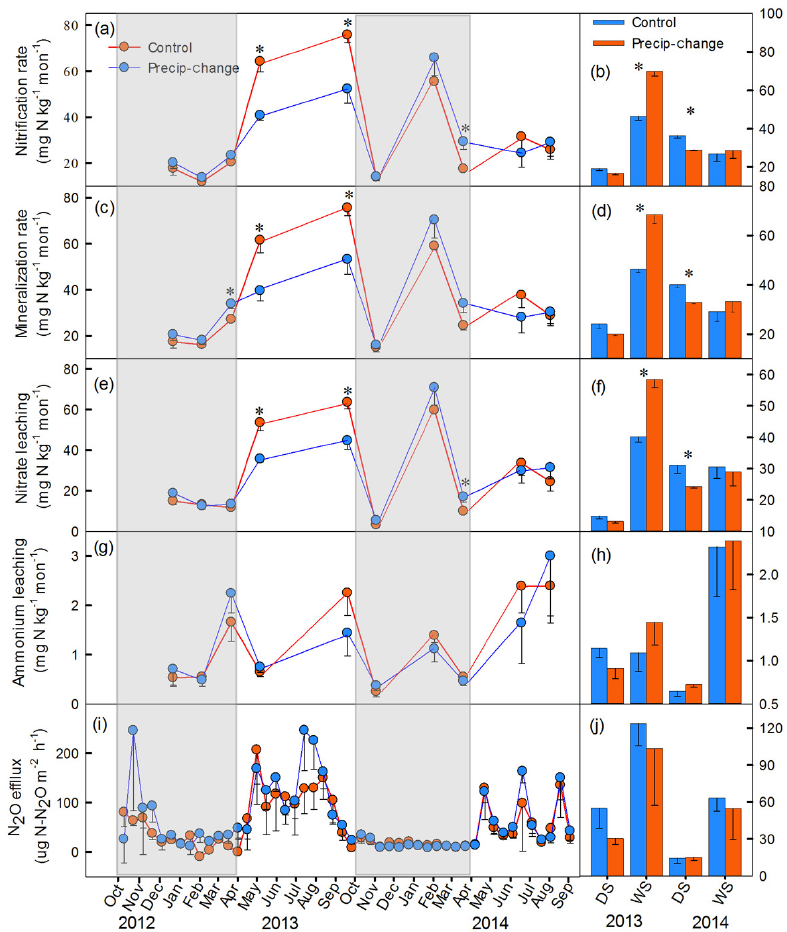
Figure 3. Nitrogen transformation rates measured in control and precipitation change (precip-change) plots over the course of experiment. Points and bars with standard error ( n = 4) show mean values at each sampling time and in dry (DS) and wet (WS) seasons. Grey shades indicate the periods of precipitation reduction. The significance levels are presented as ∗ p < 0 .